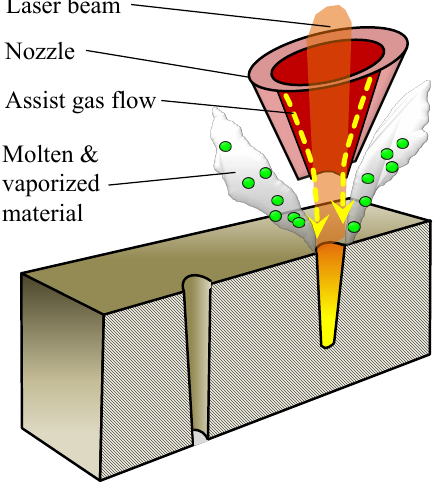
Figure 1. Schematic of a laser drilling